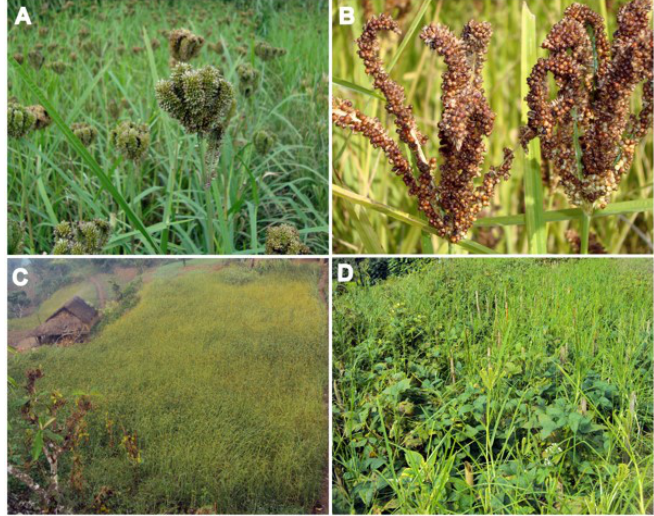
Figure 1. Illustrations of finger millet cultivation. Typical finger millet seed heads at a young stage ( A ) and at maturity ( B ) in farmers’ fields in Nepal. The seed heads resemble the fingers of a human hand. ( C ) Finger millet growing in a terraced field on a smallholder farm in Nepal. ( D ) Mixed-cropping of finger millet with soybean in a terraced field of a smallholder farmer in Nepal. Picture sources: LI-BIRD photo